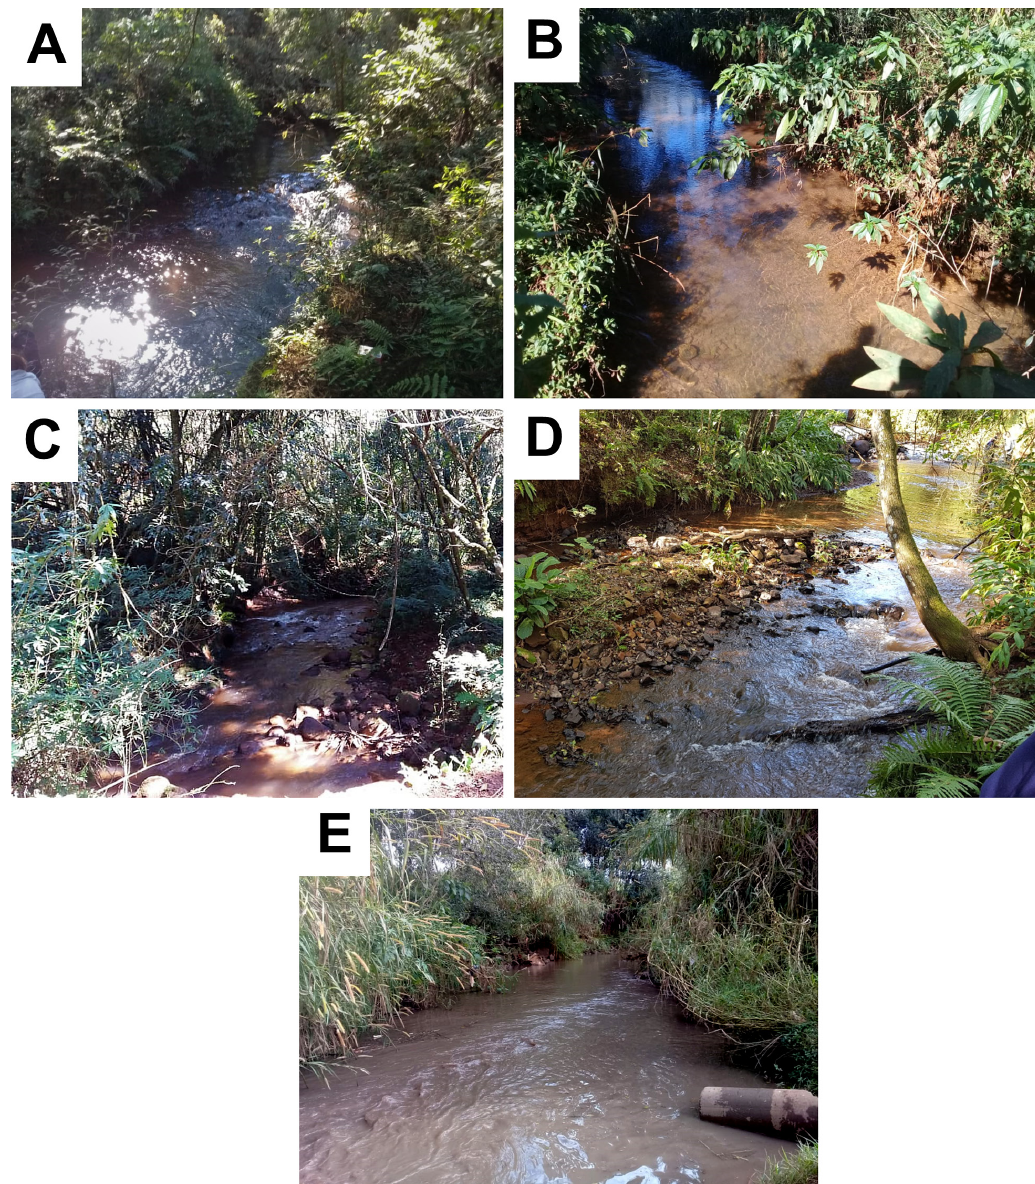
Figure 5. Localities where Astyanax bifasciatus specimens were recorded in Piquiri river basin, upper Paraná river basin. A. Ano Novo. B. Barreiro, both from sub-basin of the Tourinho River. C. Piquirizinho. D. Carreira, both from sub-basin of the Piquirizinho River. E. Aroeira, from sub-basin of the Melissa